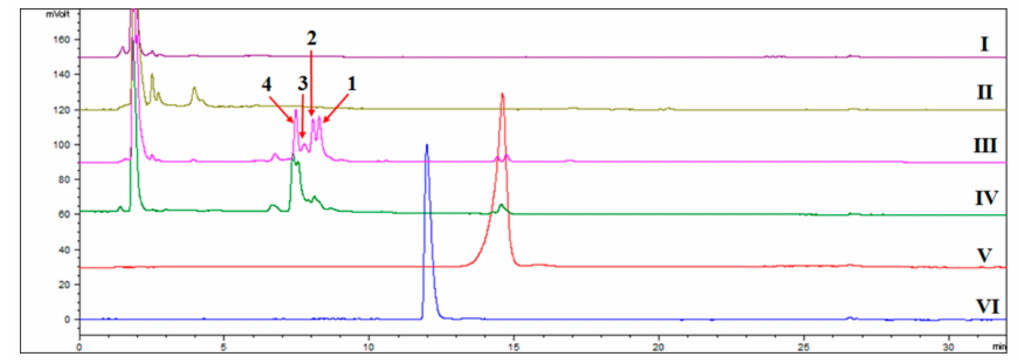
Figure 1. HPLC-ELSD detection of new products in suspension-cultured cells of A. annua . ( I ): The extract of the control group cultured under dark conditions; ( II ): The extract of the control group cultured under light conditions; ( III ): The extract of suspension-cultured cells in the presence of arteannuin I/J cultured under dark conditions; ( IV ): The extract of cultured cells in the presence of arteannuin I/J cultured under light conditions; ( V ): arteannuin I/J; ( VI ): artemisinin; 1 : 6-hydroxy arteannuin I; 2 : 1-hydroxy arteannuin I; 3 : 2-hydroxy arteannuin J; 4 : 14-hydroxy arteannuin